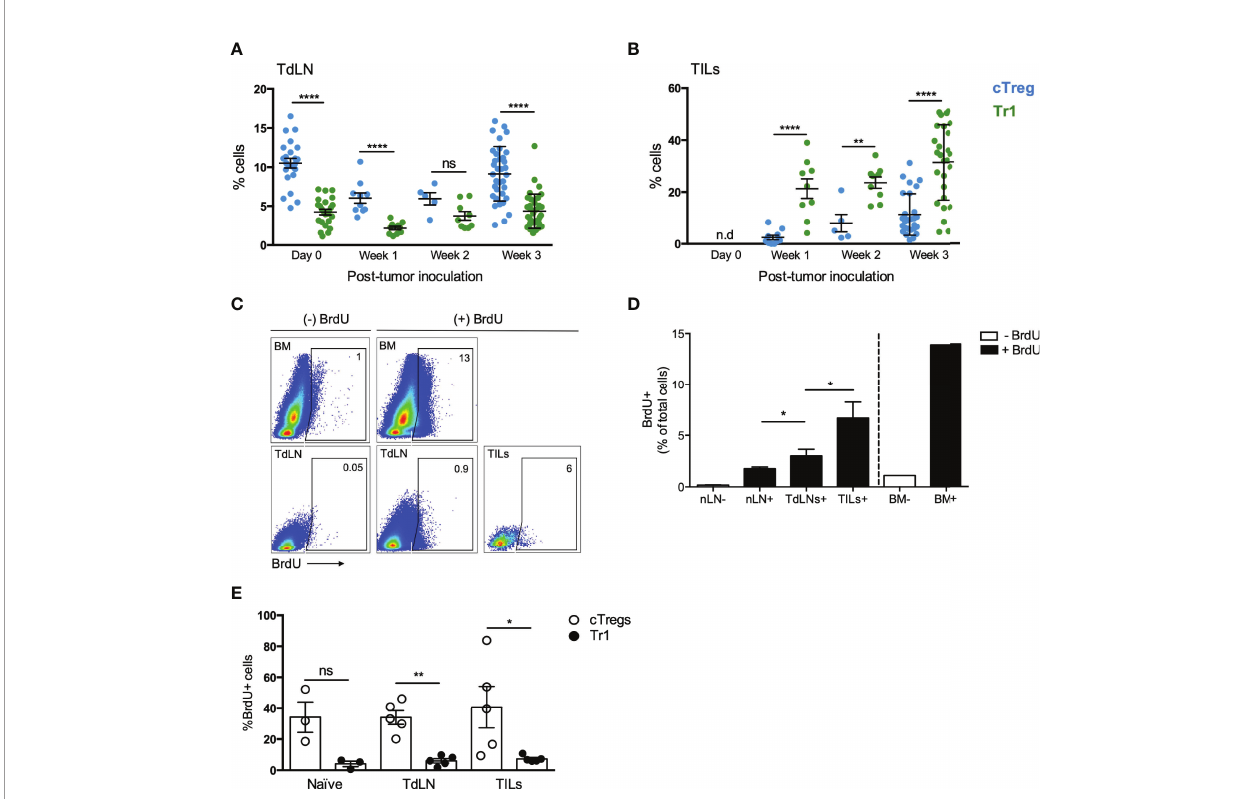
FIGURE 2 | cTreg cells are highly proliferative in comparison to Tr1 cells in vivo . To evaluate the accumulation of cTreg and Tr1 cells, mice were treated as described in the legend of Figure 1 . Mice were euthanized after 1-, 2-, or 3-week post-inoculation for analyzing the frequencies of cTreg and Tr1 cells in TdLN (A) and TILs (B) . In another set of experiments, tumor-bearing animals were used to study Treg cells proliferation through the injection of BrdU at days 12 and 15 after tumor induction (more details in Materials and Method ). Organs were harvested at day 20, including bone marrow (BM) as positive control. Naive mice that had not received the BrdU injection were used as negative control. (C) Representative plot depicting BrdU+ cells from different samples. (D) Graph showing the frequencies of BrdU+ cells in different tissues: naive lymph nodes of mice not injected (nLN − , negative control) or injected with (nLN+), tumor-draining lymph nodes (TdLN+), and tumor-in fi ltrating lymphocytes (TILs+) of mice injected with BrdU, and BM of mice injected or not with BrdU (BM+, positive control; BM − negative control). (E) BrdU+ cells on cTreg and Tr1 cells populations in inguinal lymph nodes of naive animals, TdLNs, and within the tumor. All results are shown as mean ± SEM. n = 2 – 5. * p < 0.05; ** p< 0.01; ****p < 0.0001; ns, not signi fi cant according to Mann – Whitney